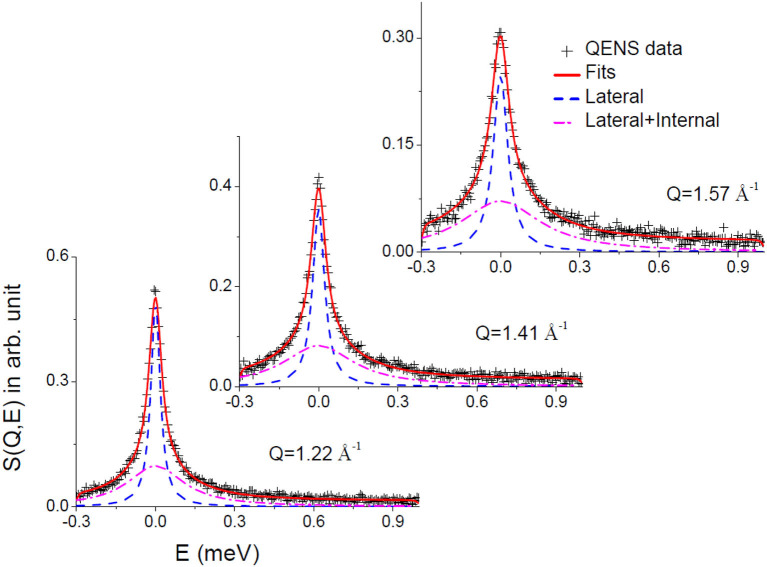
Typical fitted QENS spectra for liver lipid membrane at 57°C. Individual components corresponding to lateral and lateral with internal motions are also shown.